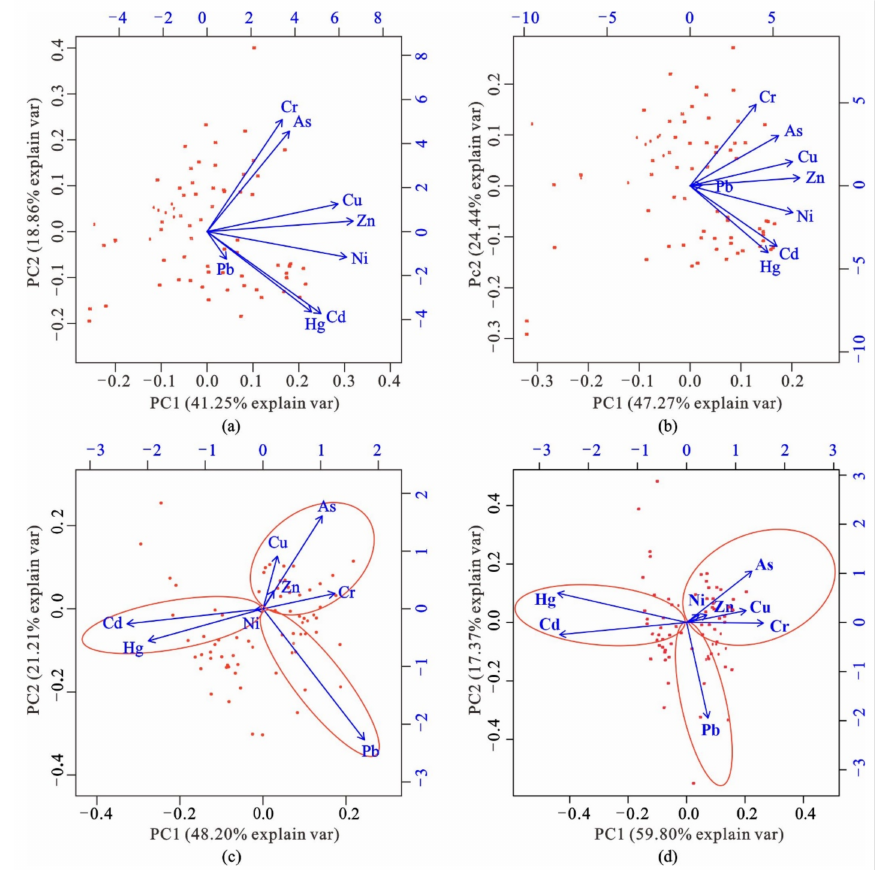
Figure 6. Principal component analysis/robust principal component analysis (PCA/RPCA) Biplot of different types of datasets in the sediments of Chagan Lake. ( a ) raw datasets by the PCA, ( b ) logarithmic transformation datasets by the PCA, ( c ) ilr transformed datasets by the PCA and ( d ) ilr transformed datasets by the